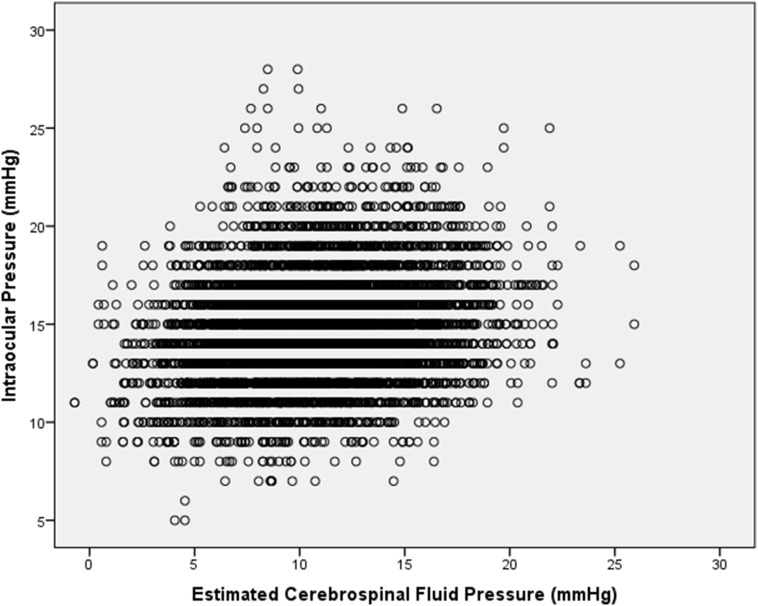
Scattergam showing the distribution of intraocular pressure and estimated cerebrospinal fluid pressure in the non-glaucomatous population of the Beijing Eye Study 2011.